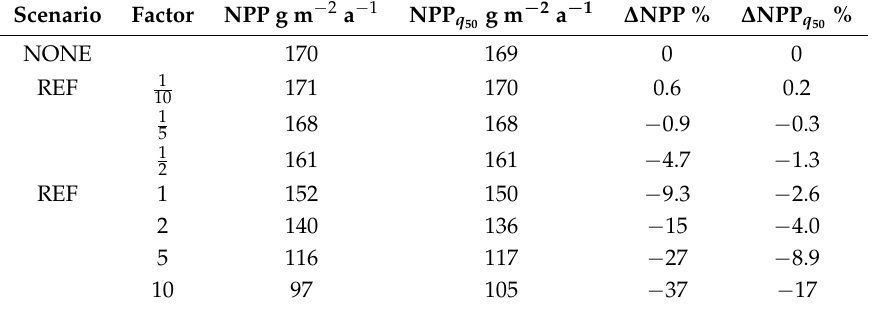
Table 2. Sensitivity to uncertainty in biomass reconstruction. Linear scaling of the benthic biomass reconstruction with factors from 10 − 1 to 10 with respect to the reference scenario (REF) and the